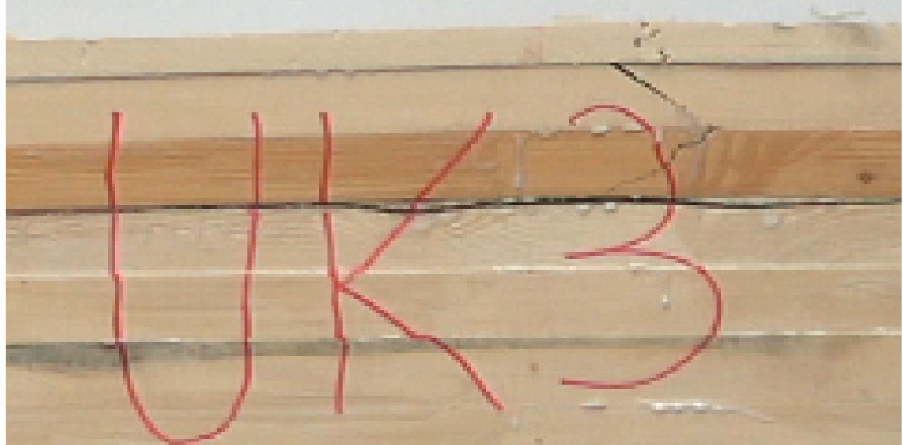
Figure 4. Failure of joint in beam-type